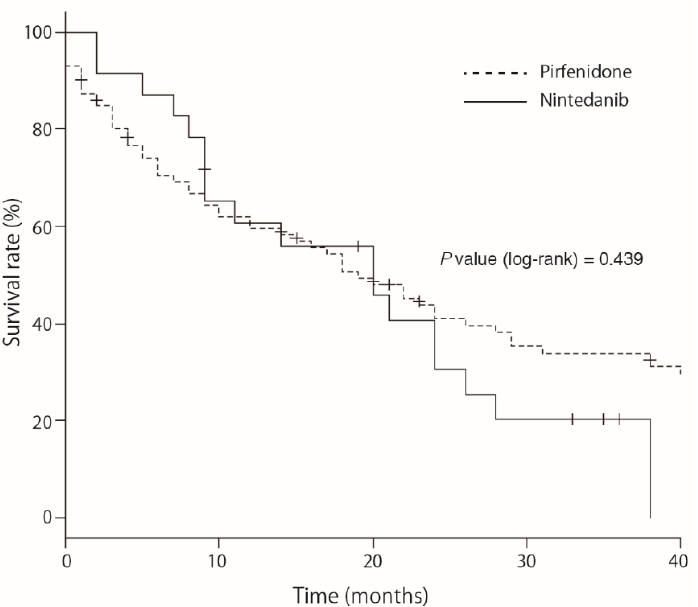
Figure 4. Kaplan-Meier survival analysis between pirfenidone and nintedanib treatment in patients with idiopathic pulmonary fibrosis. with idiopathic pulmonary